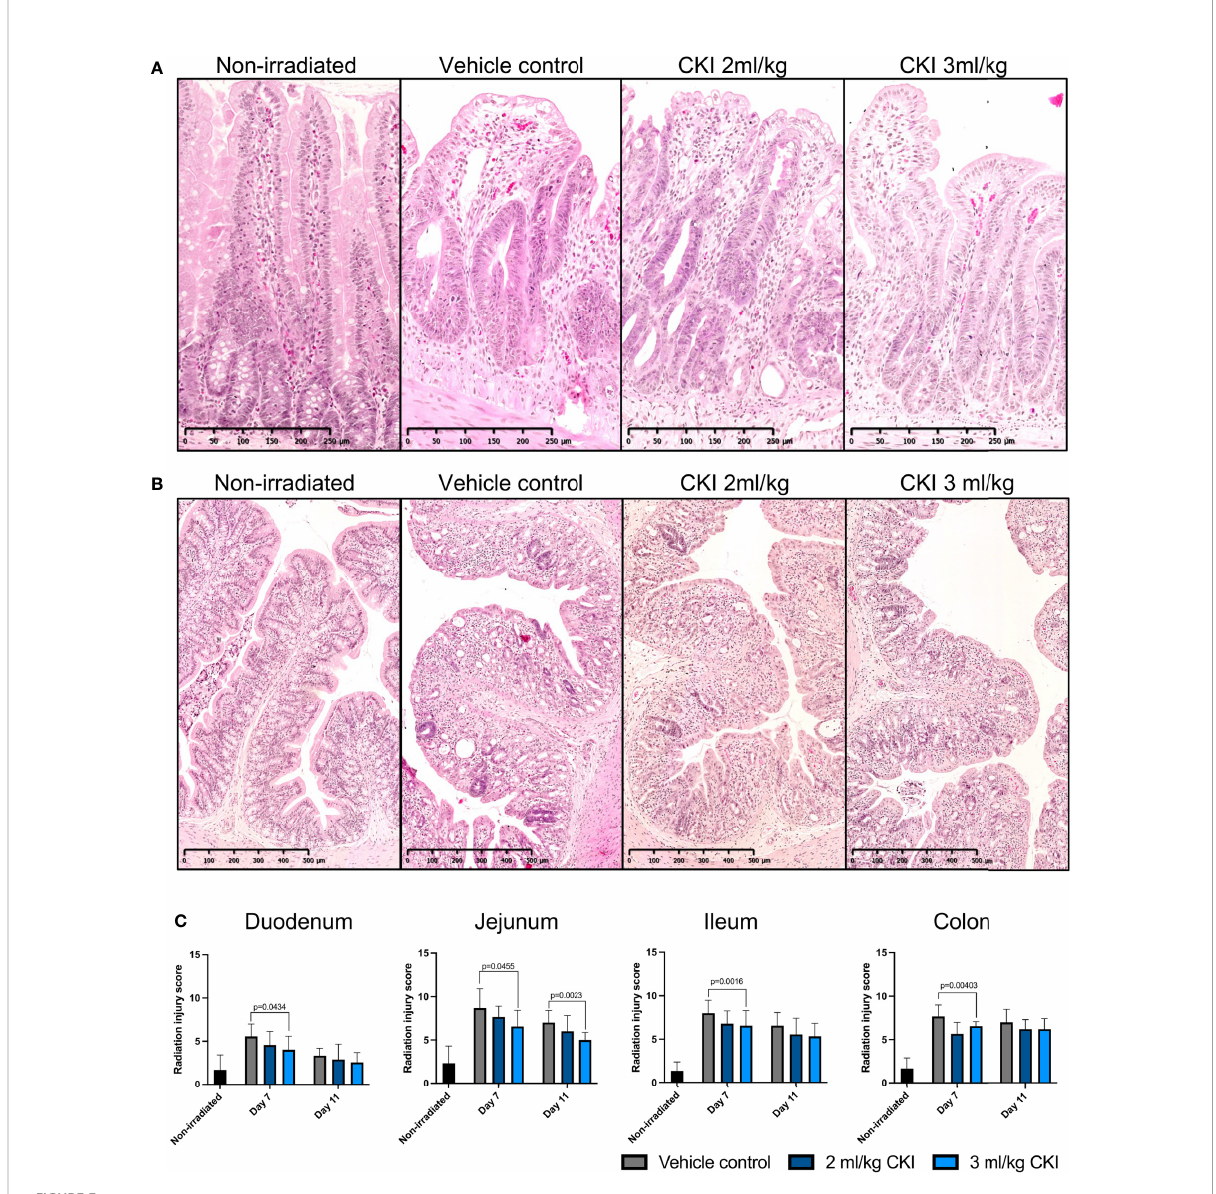
FIGURE 3 Administration of CKI reduces radiation-induced mucosal damage. (A, B) Representative images of H & E-stained jejunum (A) and colon (B) sections from day 7. The intestines were collected from irradiated rats and paraf fi n-embedded tissues were sectioned and stained with H & E. (C) Radiation injury scores of irradiated intestinal mucosa. The stained sections were analyzed and scored for grade of injury and in fl ammation as described in Materials and Methods . Data are presented as mean ±